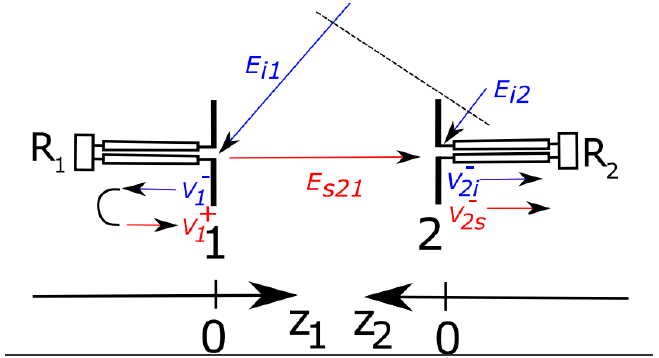
Figure 3. Scheme of mutual coupling in receive mode (2 antennas).